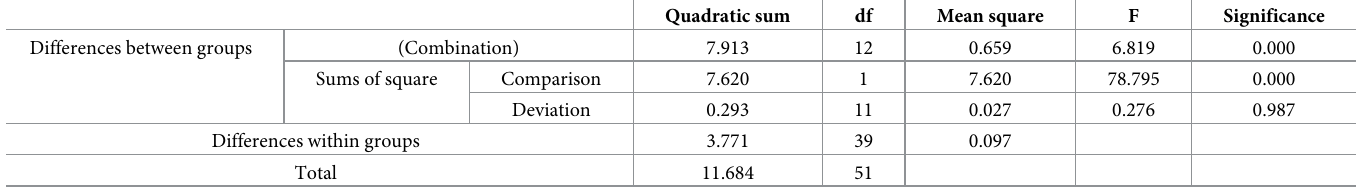
Table 3. Impact of lateral slope on variation of water-filled rut depth.